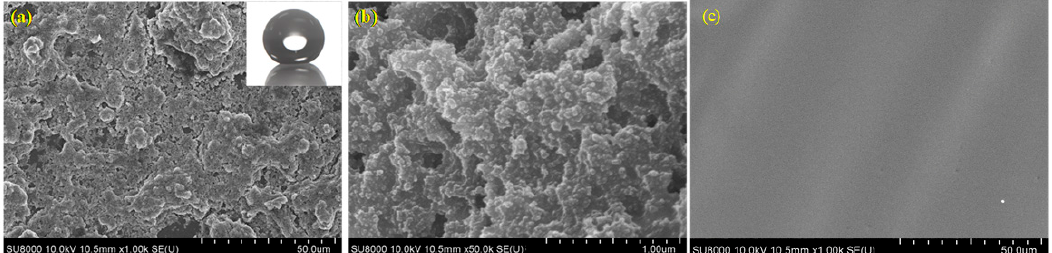
Figure 2. FE-SEM (field emission scanning electron microscope) images of the fluorocarbon superhydrophobic surface ( a ) with the magnification of 1000 times; ( b ) with the magnification of 50,000 times; ( c ) coatings without modified SiO 2